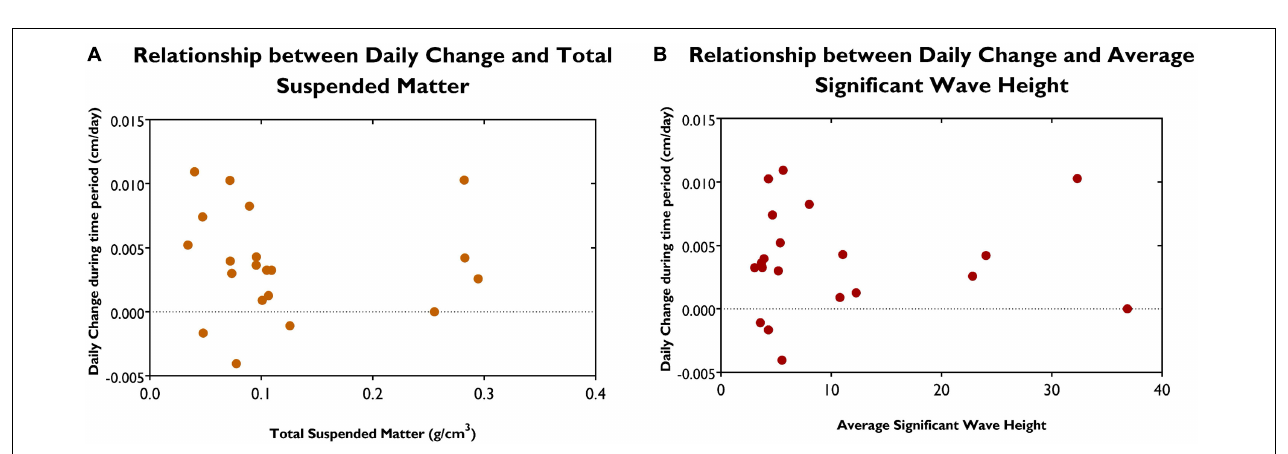
FIGURE 4 | Dumbbell plot showing long term average changes at each site.